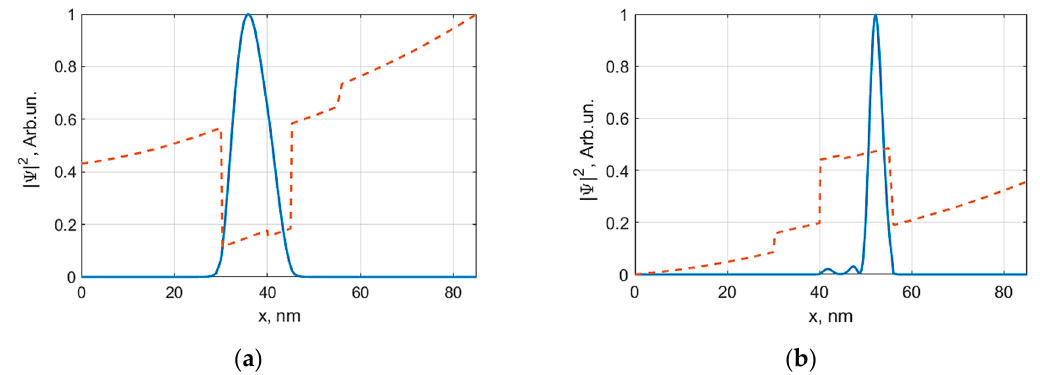
Figure 4. The probability densities (solid lines) of electron ( a ) and hole ( b ) location in the control heterostructure (10-nm LT/5-nm i -type/10-nm LT configuration) at the end of the carrier relocation process. The profiles of the valence band top and conduction band bottom (dashed lines) are given for reference.